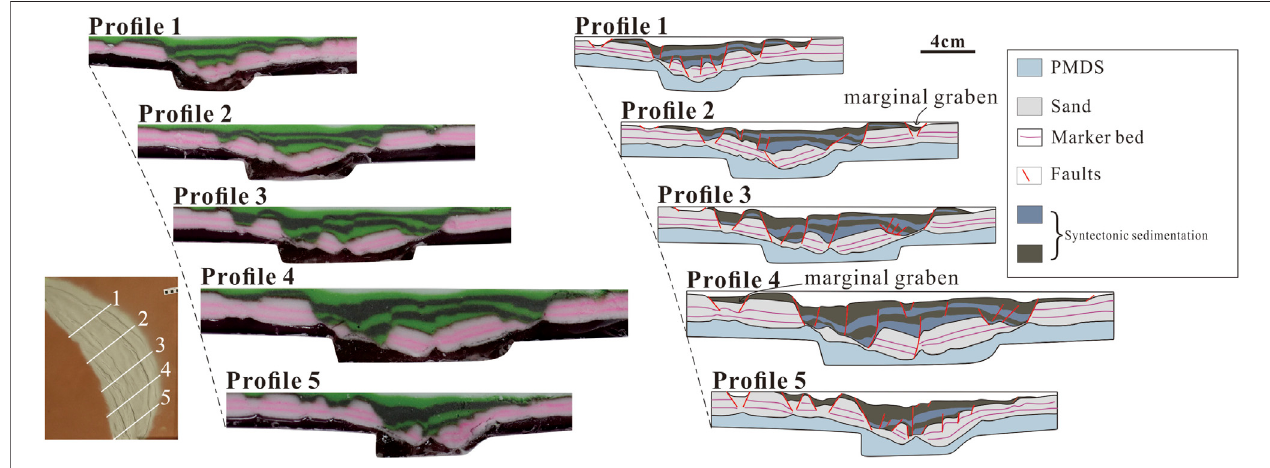
FIGURE 8 | Serial sections through the transrotational model. Location of sections is indicated in the inset (left corner).